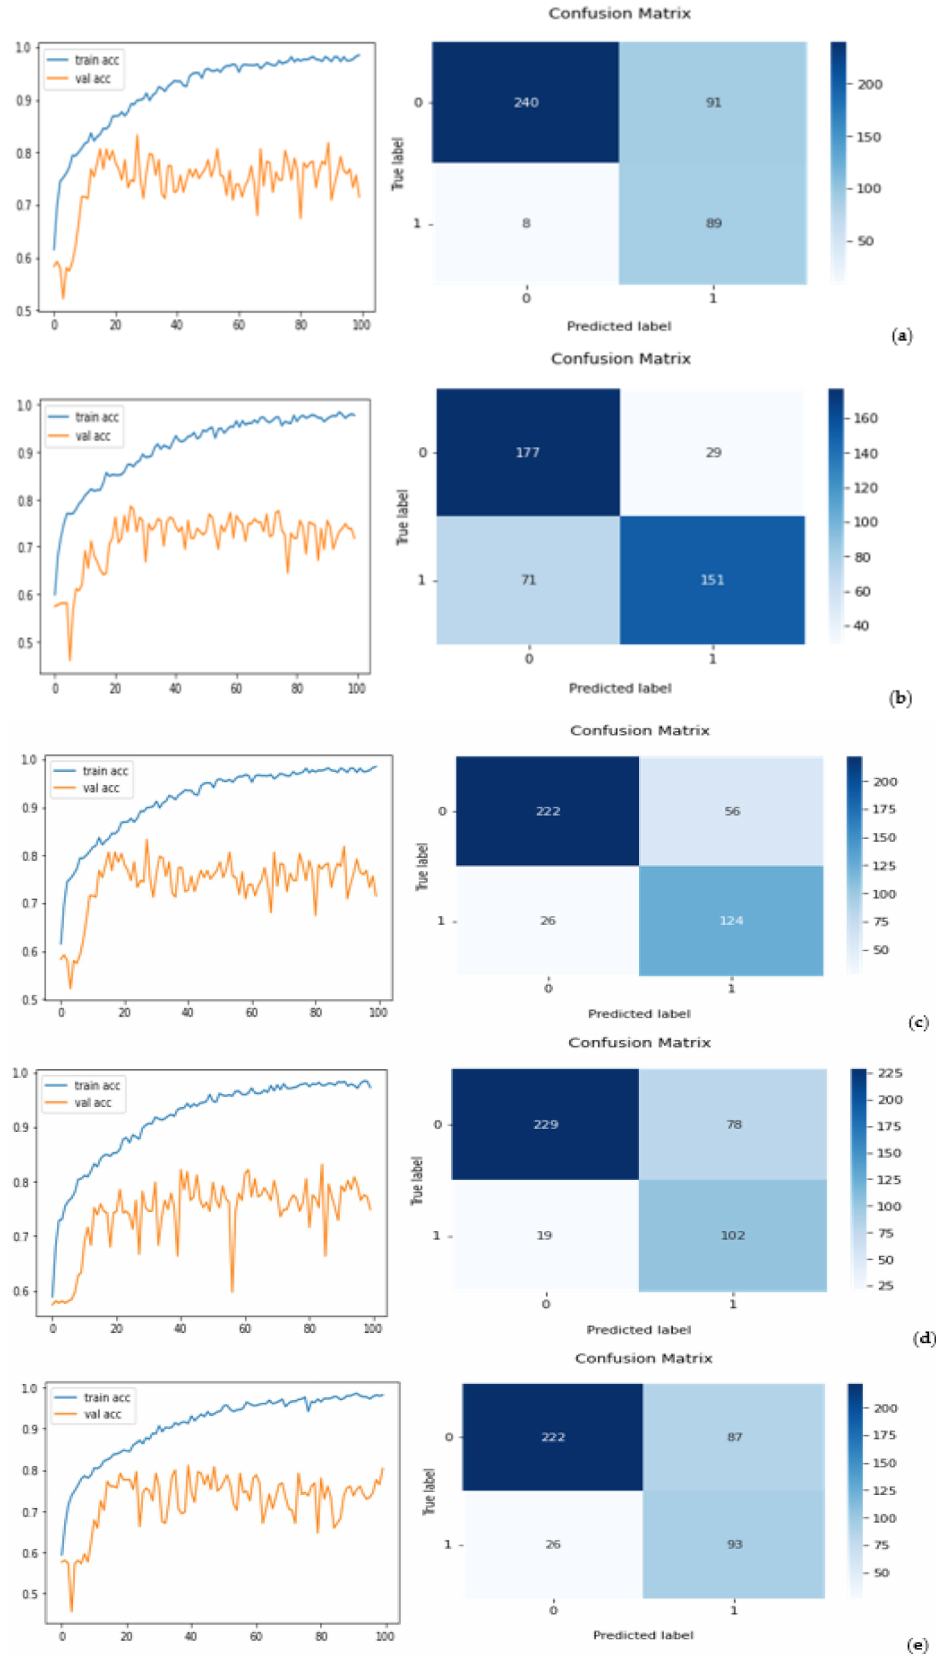
Figure 8. Left column show five sets of performance curves ( a – e ) of the ResNet50 model